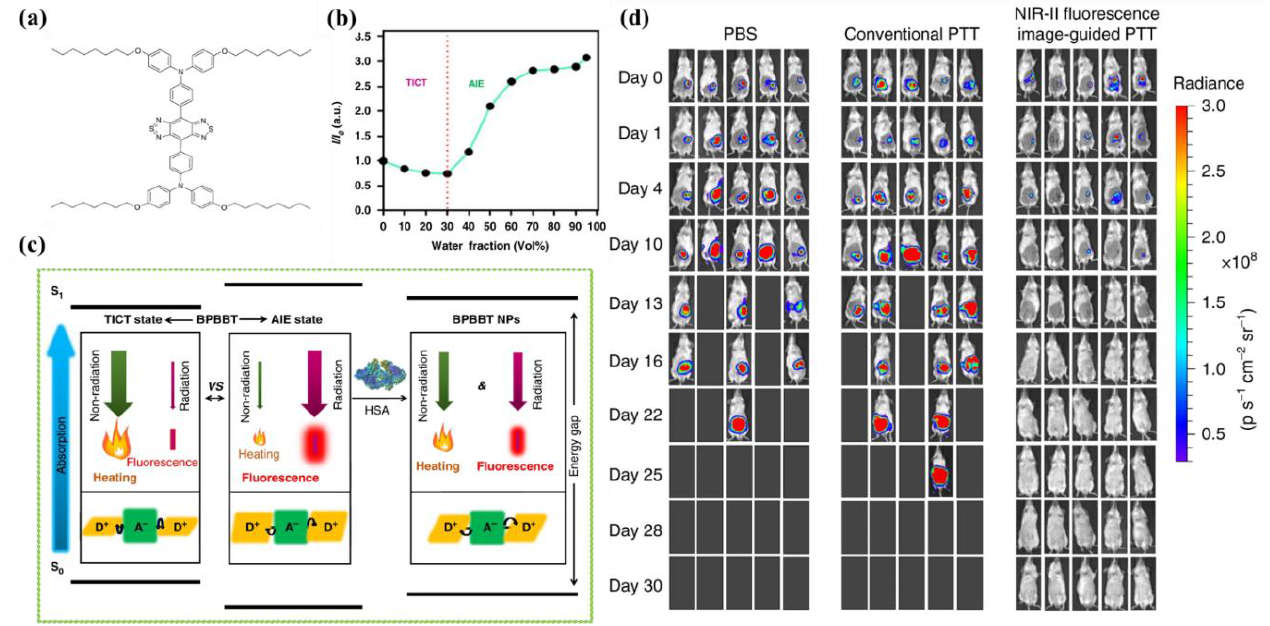
Figure 2. ( a ) Chemical structure of BPBBT; ( b ) plot of fluorescence intensity ratio of BPBBT (10 µM) in water/THF mixture; ( c ) the illustration of has-altering radiative decay and nonradiative decay of BPBBT; ( d ) the in vivo fluorescence imaging of BALB/c mice bearing orthotopic CT26 colon cancer before or after different treatment (n = 5). Reprinted with permission from Ref. [47]. Copyright 2019, Nature Publishing Group.